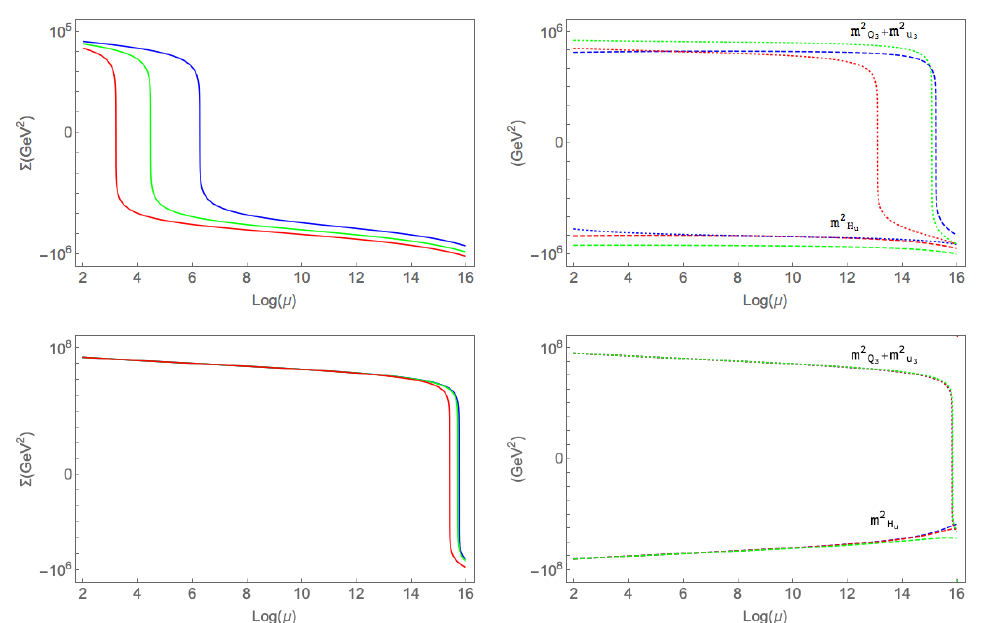
Figure 3 . Evolution of the parameter (cid:6) to the infrared (cid:12)xed-point and soft mass parameters input at (cid:3) = 10 16 GeV with m 2 = m 2 = (cid:0) 10 5 GeV 2 , A t = (cid:0) 100 GeV and tan (cid:12) = 10. The (cid:22) u 3 Q 3 three separate curves are shown for di(cid:11)erent initial values of: Top Row: M 3 = 100 GeV ; m 2